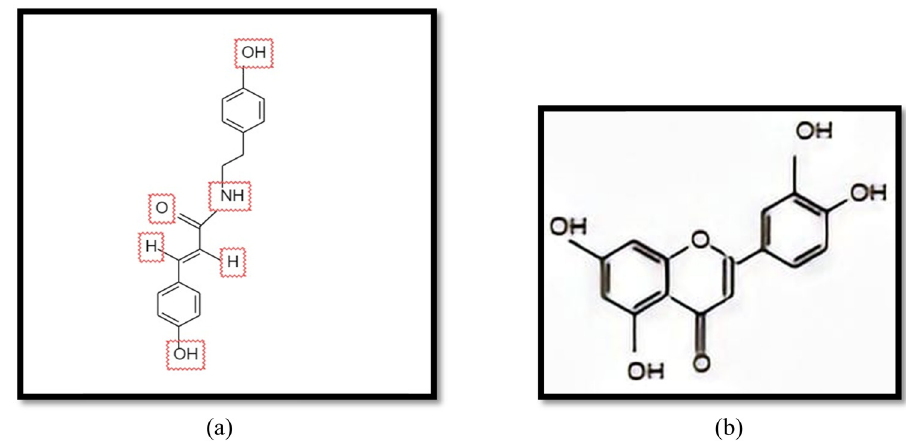
Figure 4: Structures of ( a ) N - p - coumaroyltyramine and ( b )